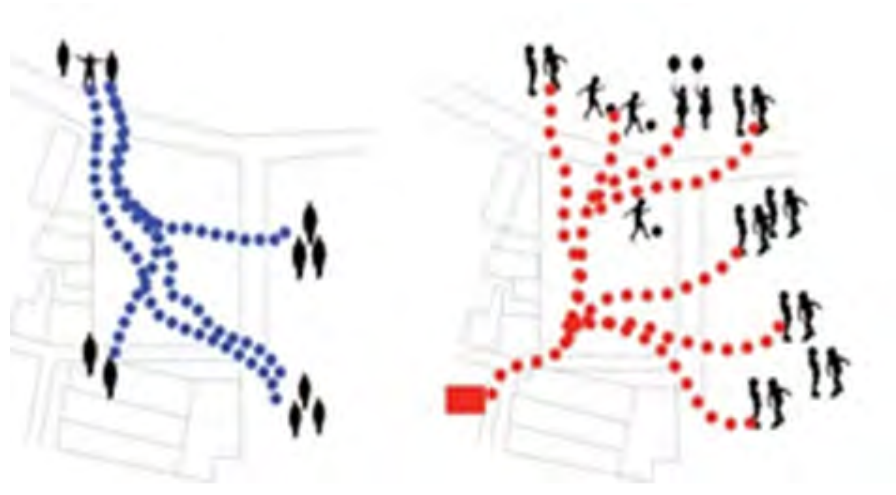
Figure 14. Pedestrian routes (“Ahmed Shemisah’s” Project)